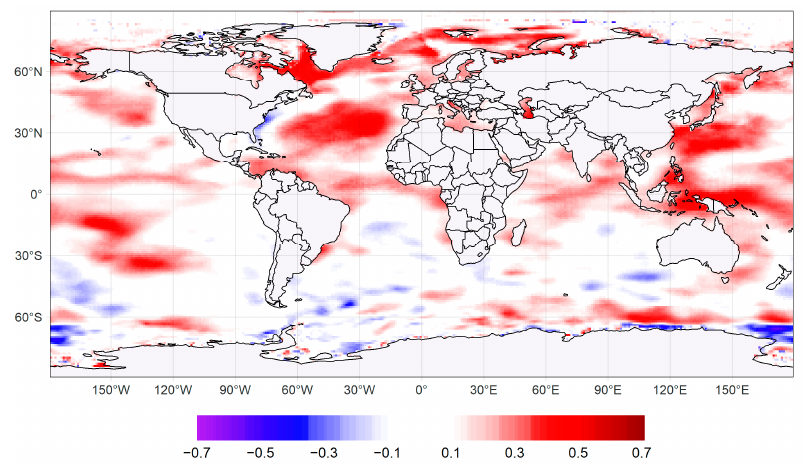
Figure 8. Spatial correlation between the annual maximum northern extent of ETCs and the annual mean SST.